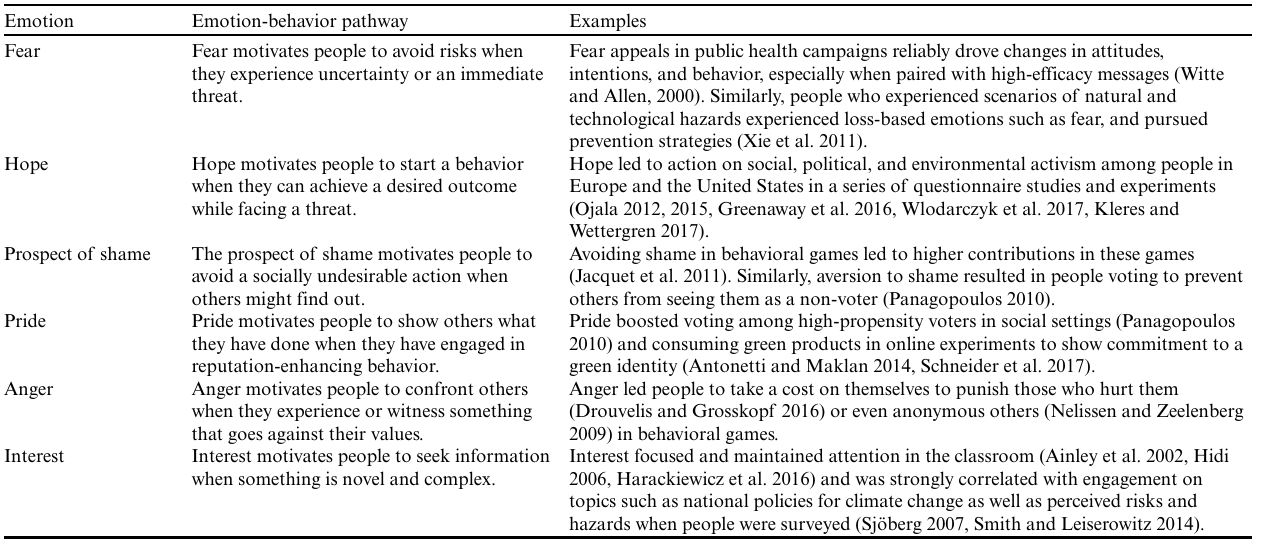
Table 1. Emotion-behavior pathways and examples for six emotions relevant for environmental behavior change. Emotion Emotion-behavior pathway